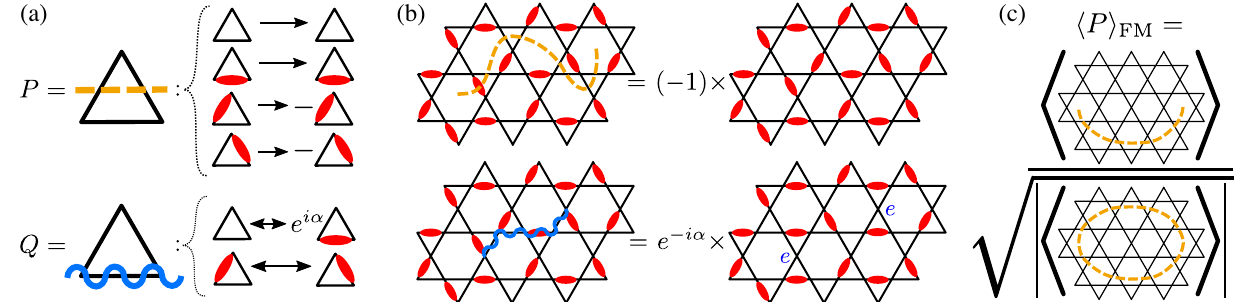
FIG. 5. Topological string operators. (a) The two different string operators are defined by their action on a single triangle. We call the diagonal and off-diagonal string operators P and Q , respectively. (b) An example of the action of the string operators on a classical dimer state. (c) The definition of the Fredenhagen-Marcu order parameter [89 – 93] is shown for the diagonal string, h P i condensation of the m anyon. The analogous definition for h Q i